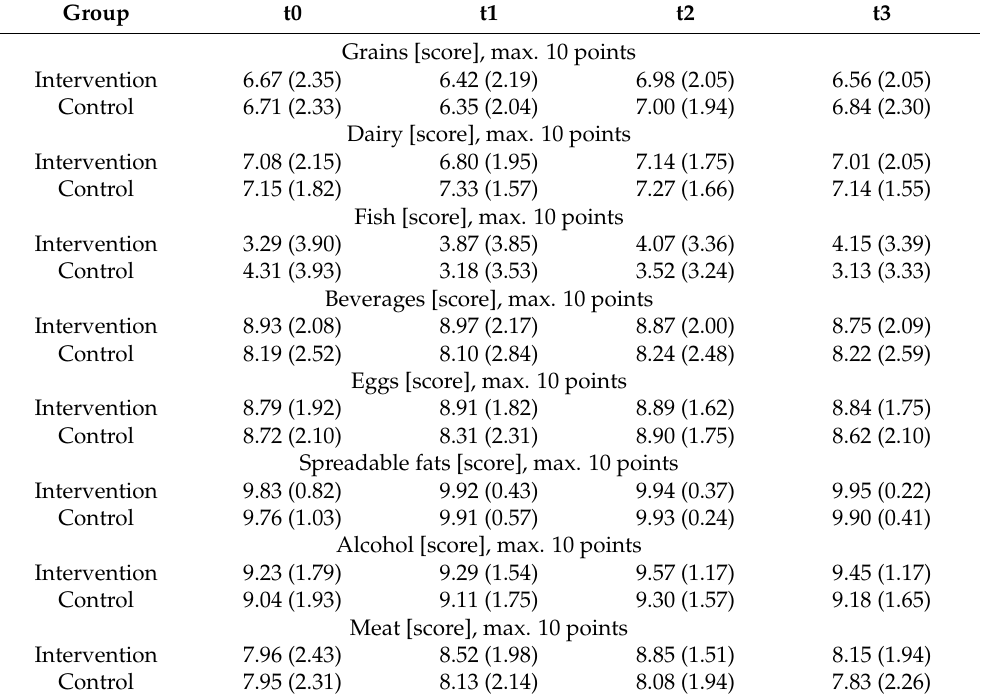
Table 3. Cont. Group t0 t1 t2 t3 Grains [score], max. 10 points